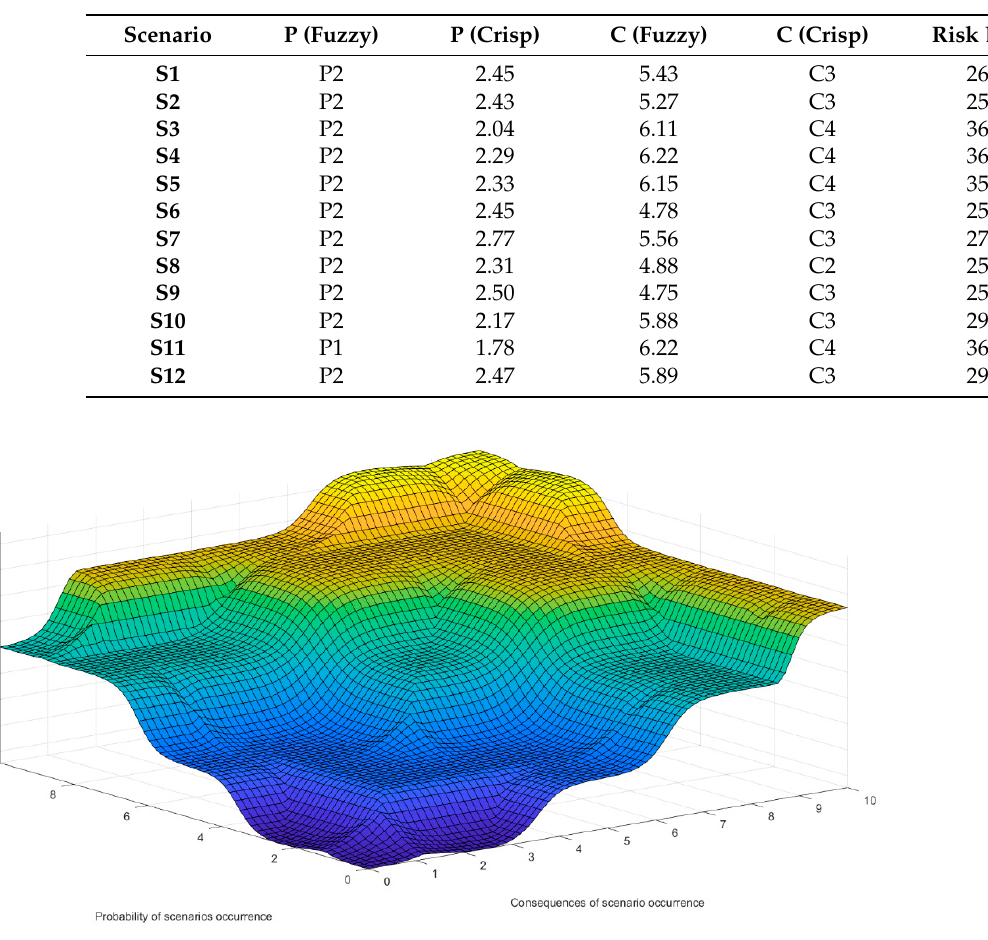
( a ) ( b ) Figure 12. Influence of the course of input functions on the obtained risk index value: ( a ) the conse- quence function of the scenario; ( b ) the probability function of the scenario.